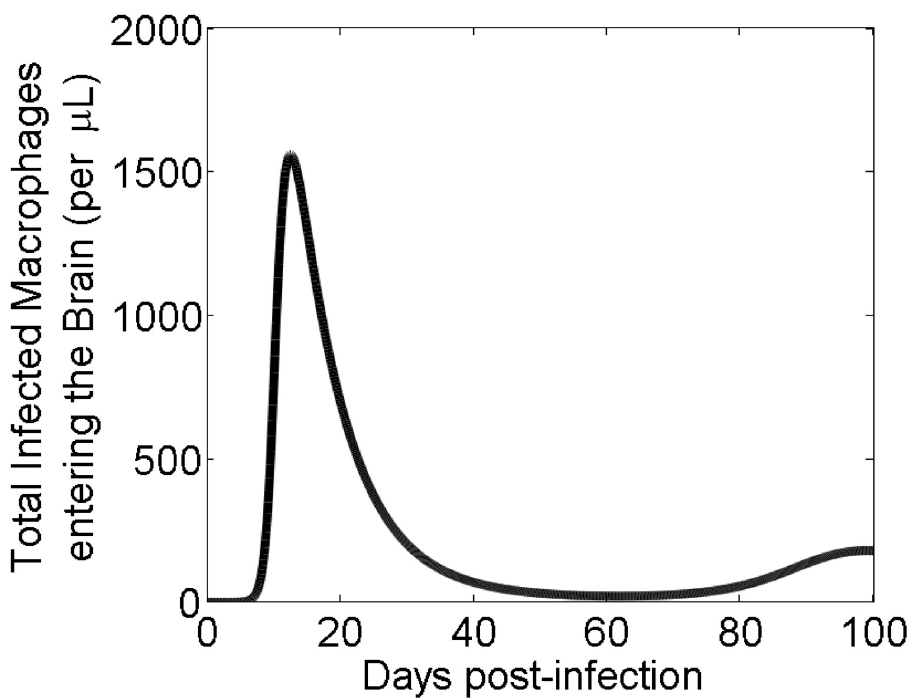
Fig 4. Incoming infected macrophages entering the brain ( φM � ). Model simulations of the total count of infected macrophages ( φM � ) entering the brain for 100 days post-infection.